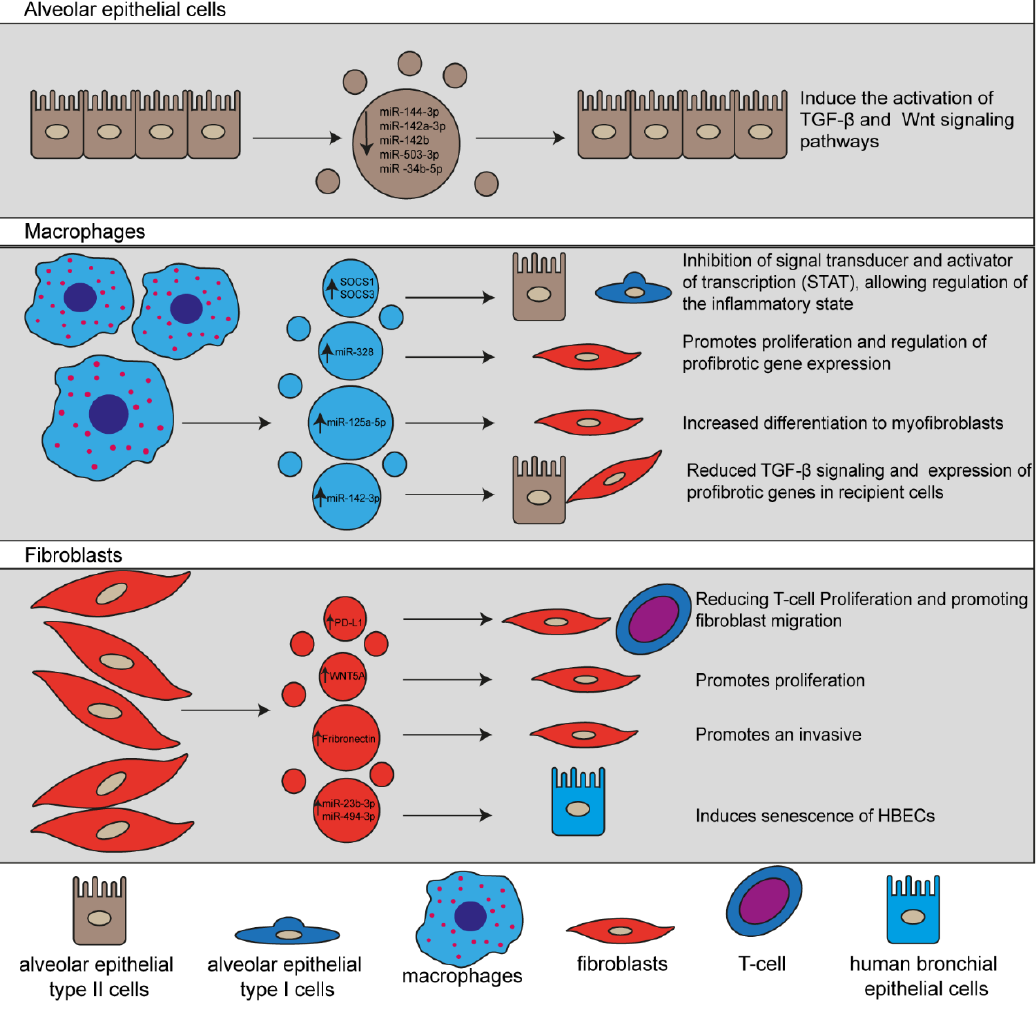
Figure 2. Schematic representation of EVs released by different lung cells involved in IPF pathogenesis. EVs and their cargo molecules regulate the main signaling pathways associated with profibrotic processes facilitating the IPF progression.